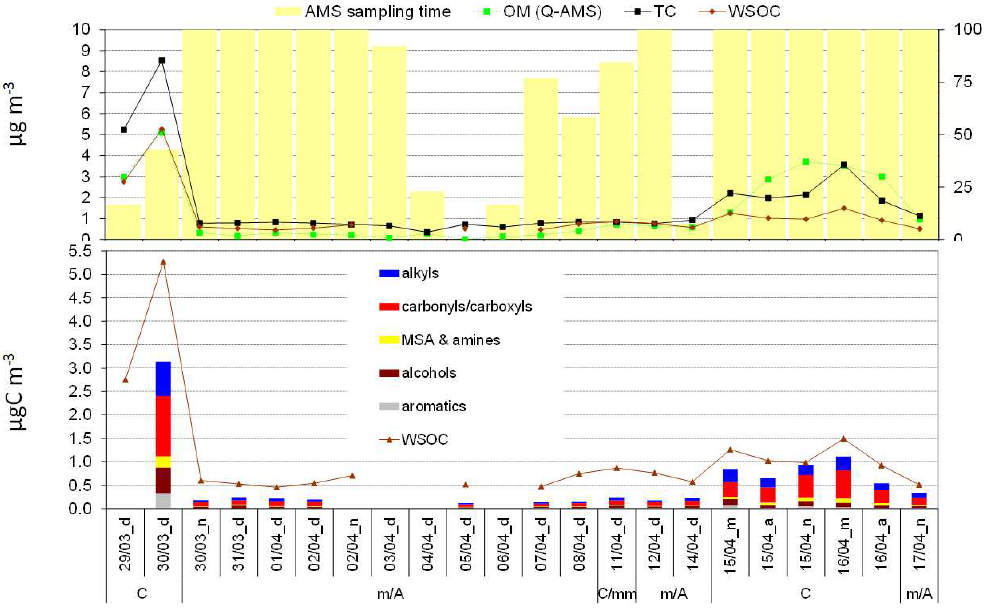
Fig. 5. Upper panel, PM 1 filter samples carbonaceous mass concentrations expressed as total carbonaceous (black), water-soluble organics in (dark brown) in µgCm − 3 . Q-AMS organics conc. (µgm − 3 ) averaged upon filter sampling times are shown in green. The coverage of filter sampling times by AMS (percentage) is reported by yellow bars. Lower panel, functional groups distribution of the NMR-detected